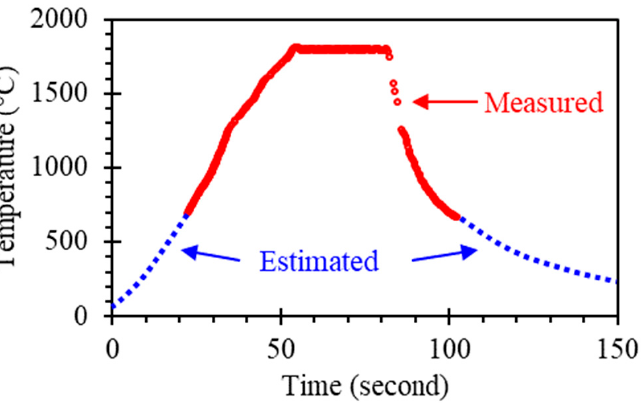
Figure 3. Measured temperature profile for CeN sintering. The dwell time at 1800 °C is approxi- mately 30 s. Temperature below 700 °C is estimated as they are outside the measurement range. See supplementary Data S1. Table 1. Samples tested at various maximum temperatures in this study.